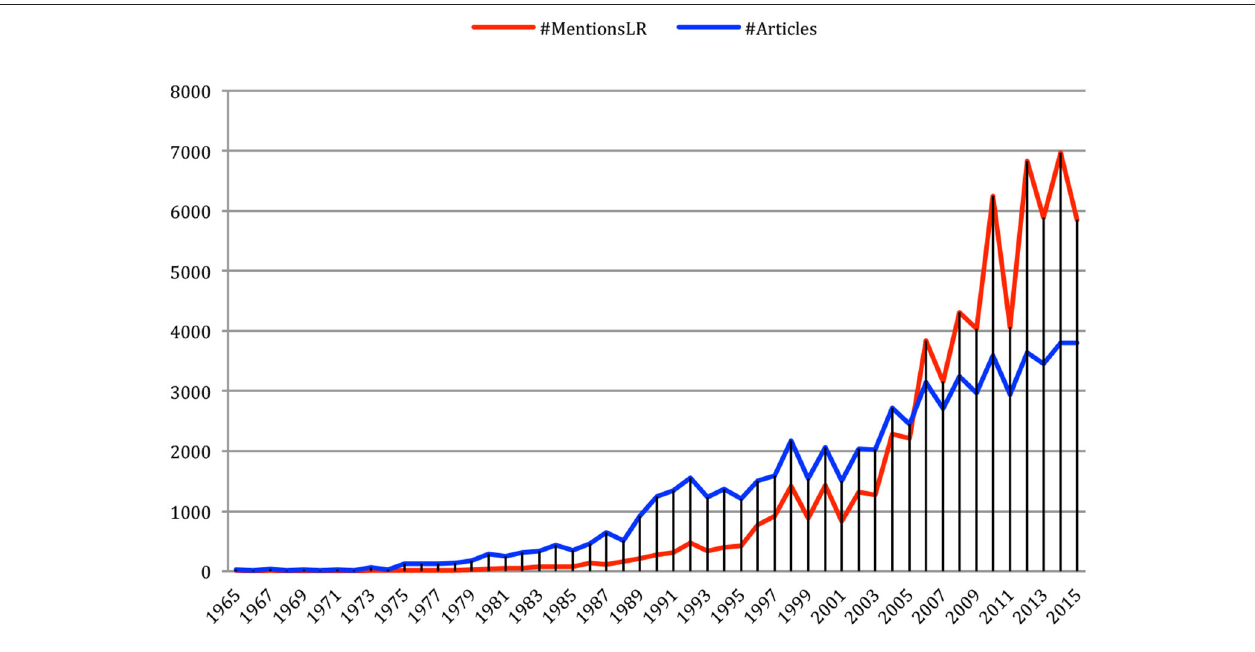
FIGURE 20 | Evolution of the number of mentions of Language Resources in papers over the